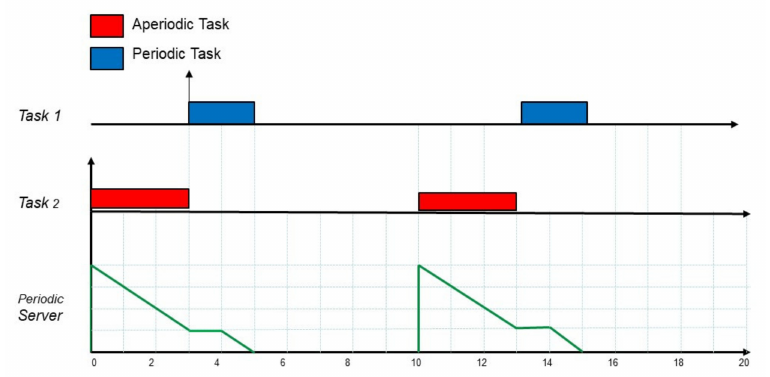
Figure 2. Periodic